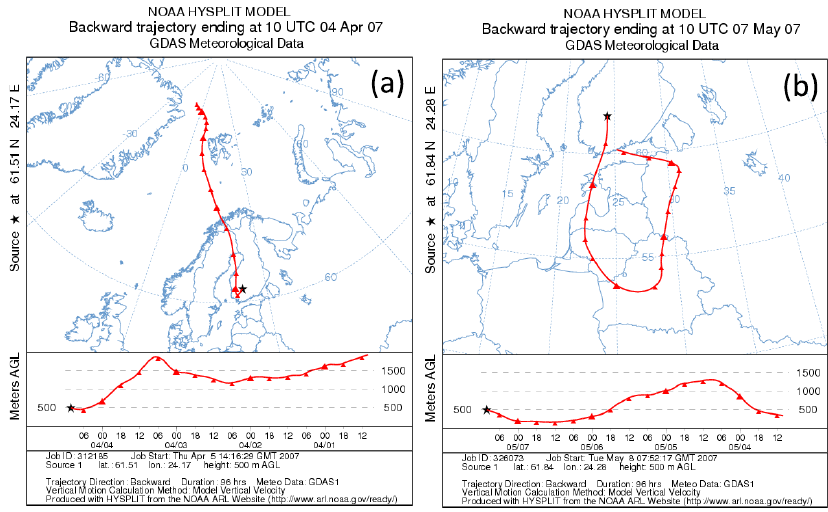
Fig. 1. HYSPLIT backtrajectories for (a) clean and (b) polluted air masses.